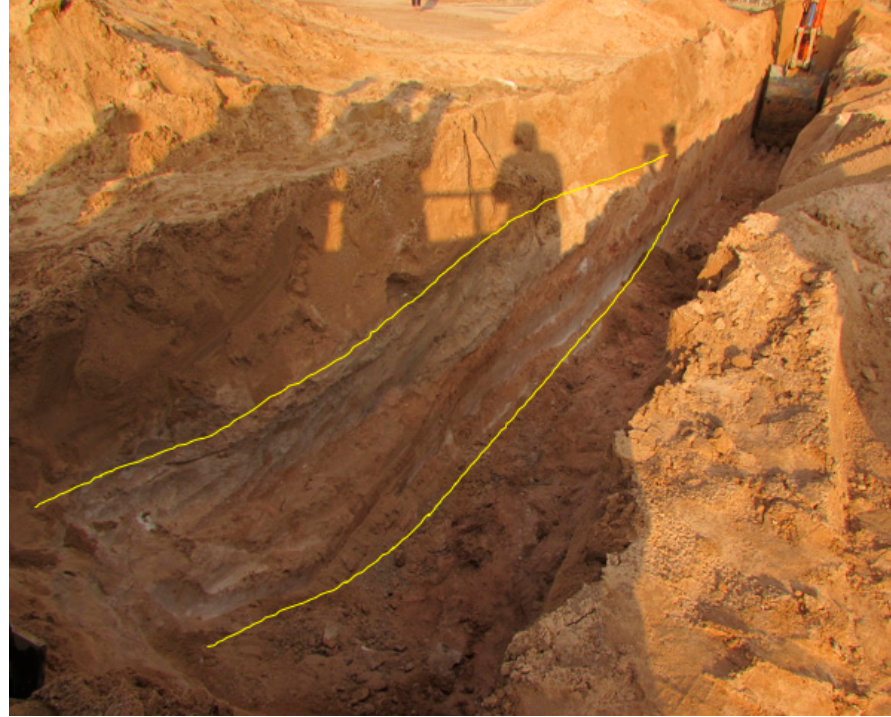
Figure 7. Trench J3 showing a cut through the natural pink sand of the landscape.